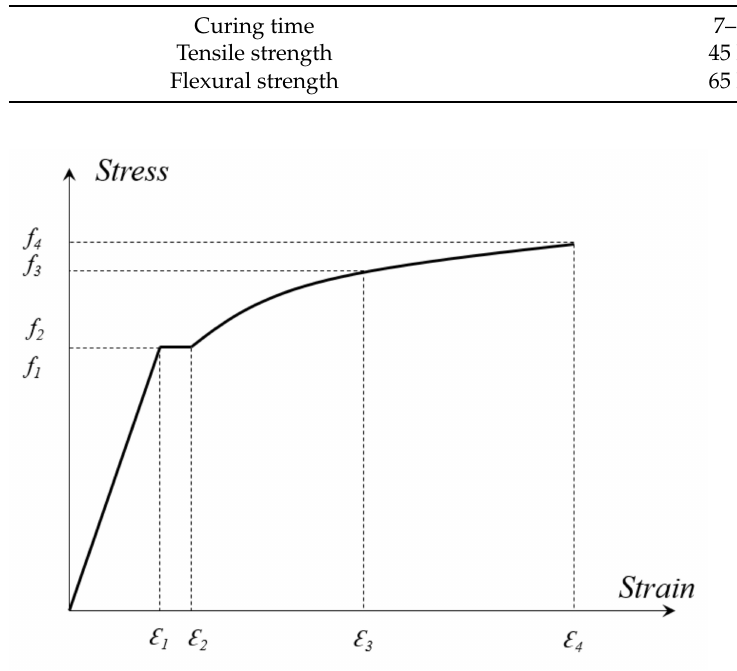
Table 4. Properties of epoxy resin.